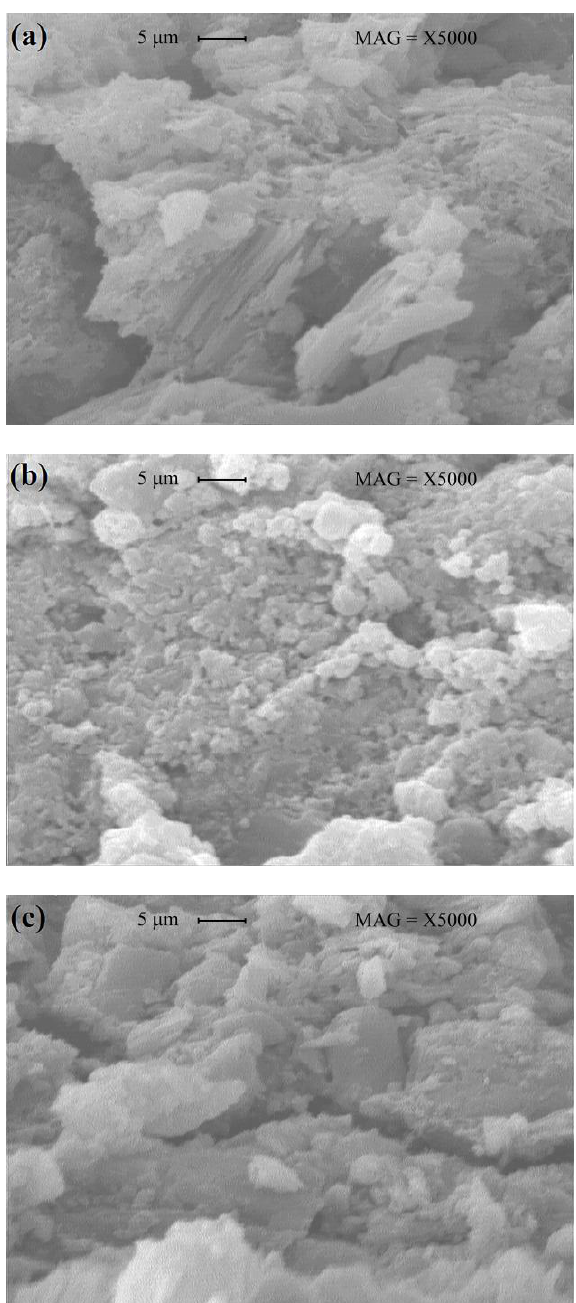
Figure 12. SEM images (5000×) of concrete mixes with ( a ) regular tap water; and ( b ) magnetized water after passing 10 times and ( c ) 80 times through a permanent magnetic field at a constant speed of 2.25 m/s.